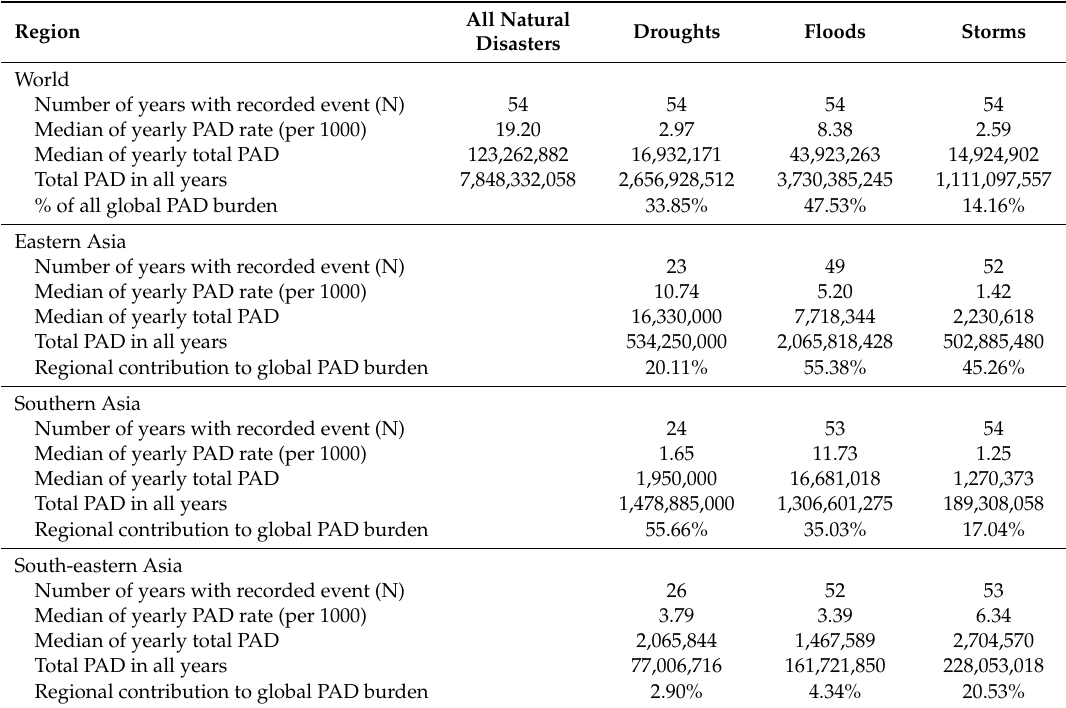
Table 1. Descriptive statistics for the total number of people a ff ected by ‘natural’ disasters (PAD) in all countries, Eastern Asia, Southern Asia and Southeast Asia. Yearly data from EM-DAT, 1964–2017. All Natural Region